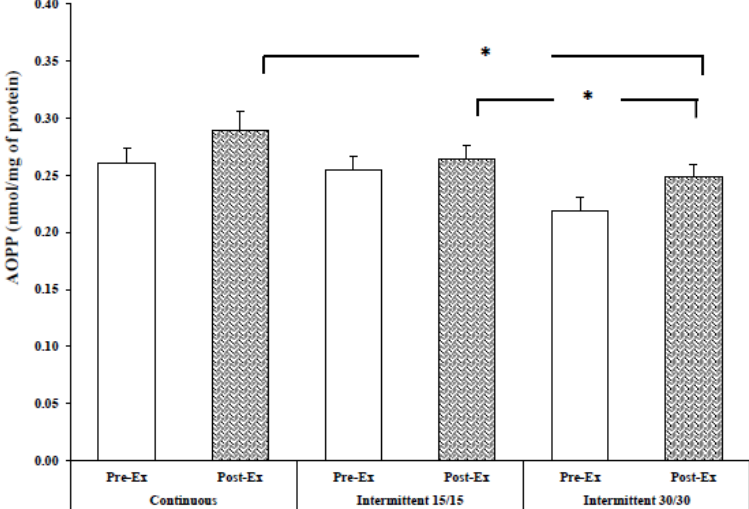
Figure 3. AOPP level at rest and immediately after exercise.